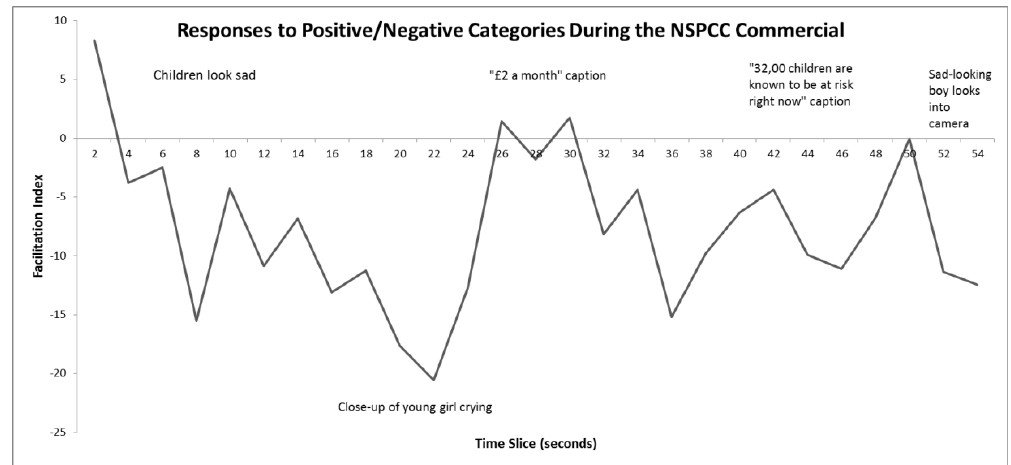
Figure 4. Three-point moving averages of facilitation indices for the Joy word set whilst viewing the NSPCC commercial. Positive scores indicate positive affect, negative scores indicate negative affect.